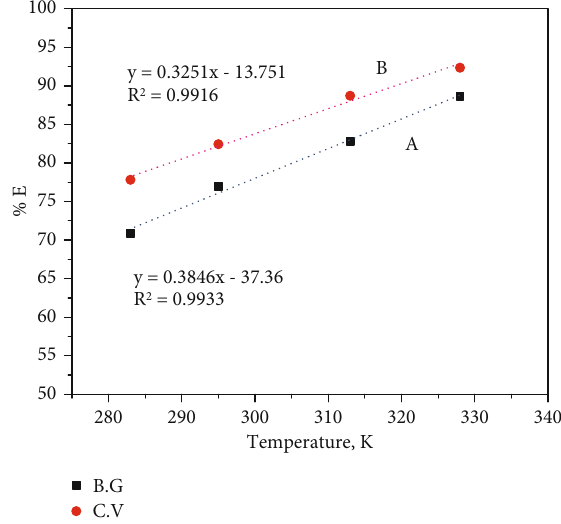
Figure 10: Impact of temperature on the sorption percentage of NCs on 2 B.G (a) and C.V (b) dyes from aqueous solutions to the surface of binary P3NT/30%AgTiO NCs at 283 K, 295K, 313 K, and 328 2